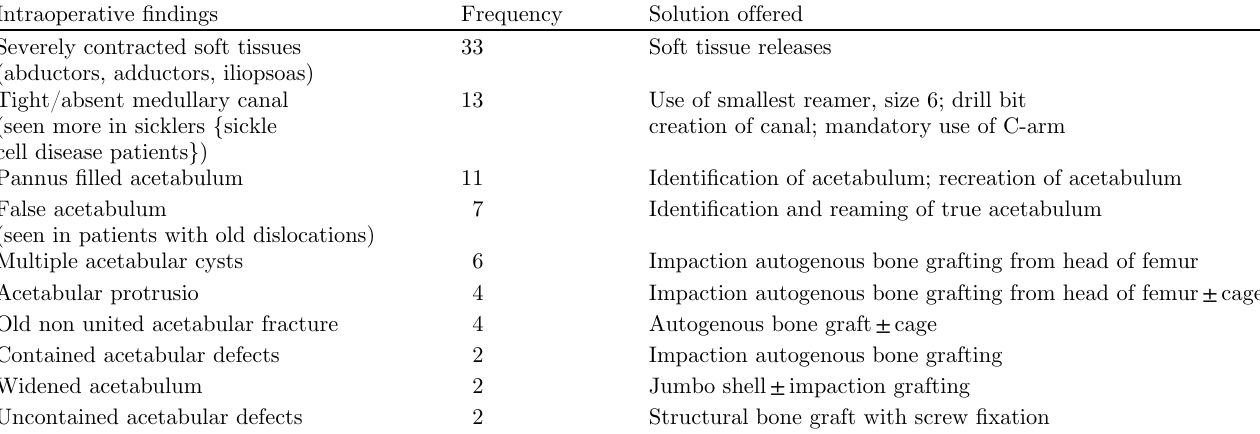
Table 2. Intraoperative fi ndings.